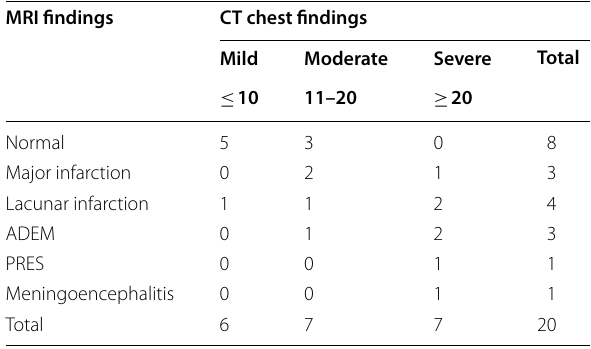
ADEM acute disseminated encephalomyelitis, PRES posterior reversible encephalopathy syndrome